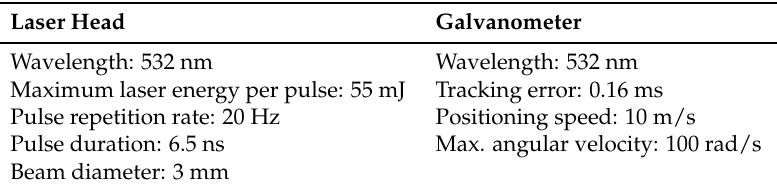
Table 1. Specifications of the laser system.